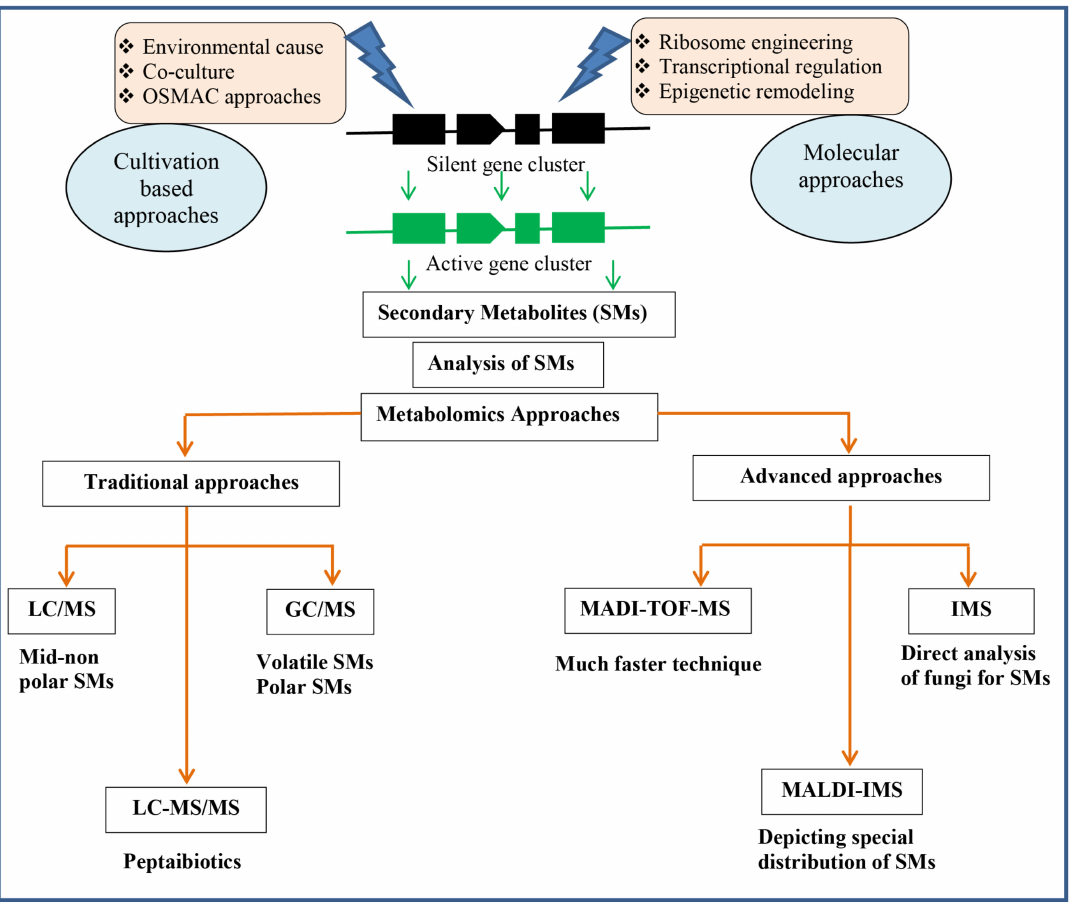
Figure 13. Schematic presentation of approaches for the analysis of SMs in Trichoderma